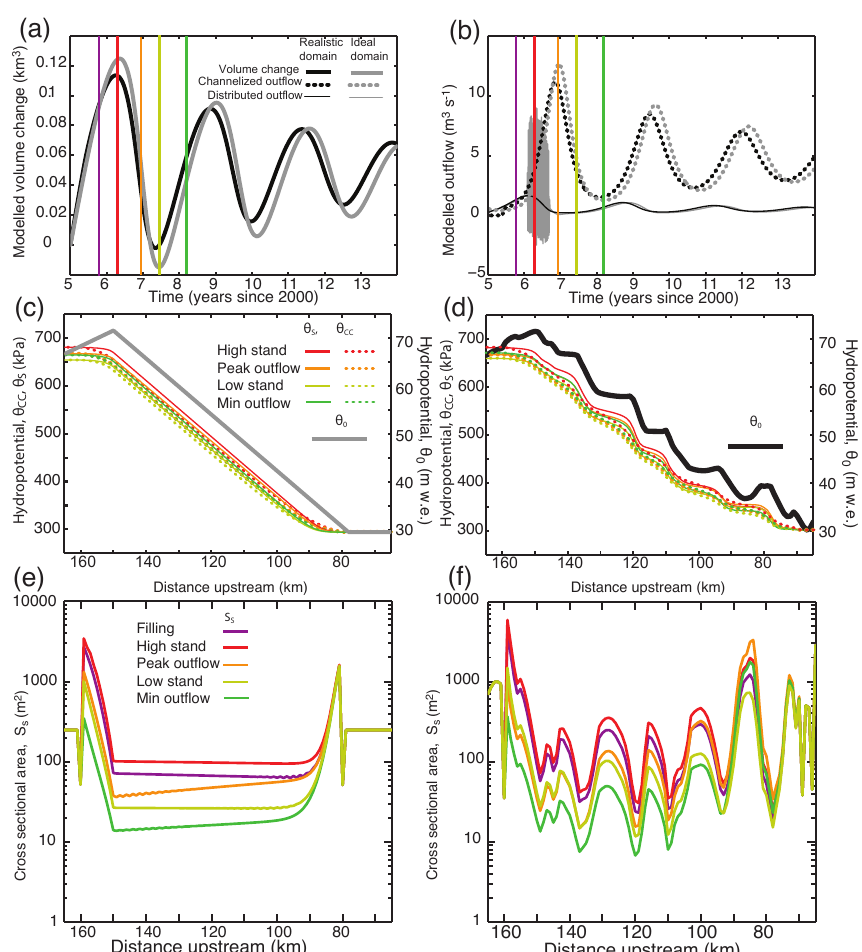
Figure 7. Comparison between canal model executed on the idealized and realistic domains. From top to bottom, pairs of panels show (a) modeled volume change and (b) modeled outflow; evolution of hydropotential in the canal ( θ CC ) and in the distributed system ( θ S ) compared to ice base hydropotential ( θ 0 ) on the (c) idealized and (d) realistic domains; and evolution of cross-sectional area of the distributed system ( S S ) on the (e) idealized and (f) realistic